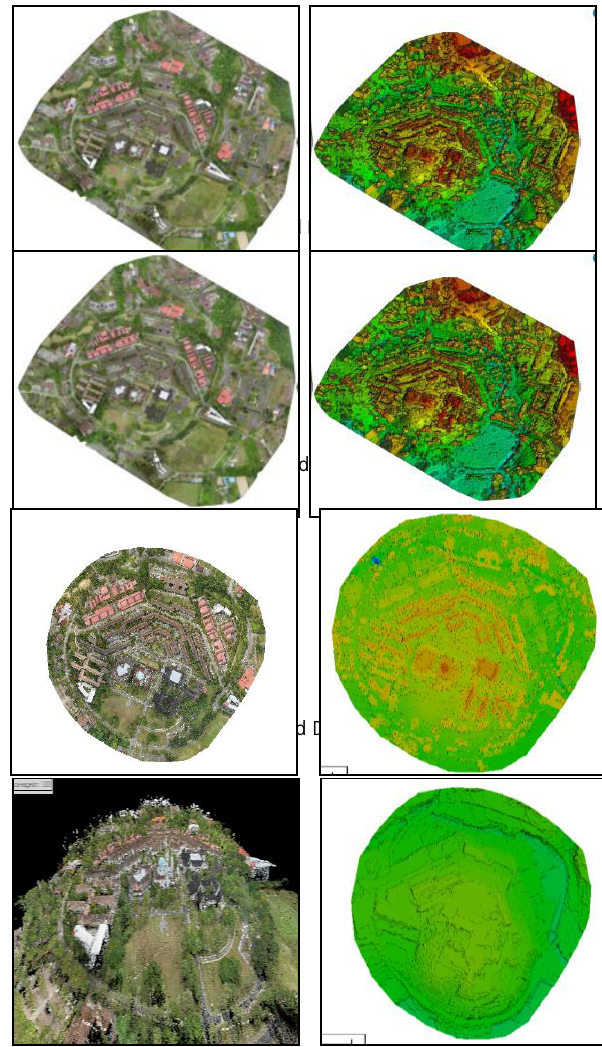
Figure 6. Orthophoto (Left) and DEM (Right) from Riegl UAV Lidar